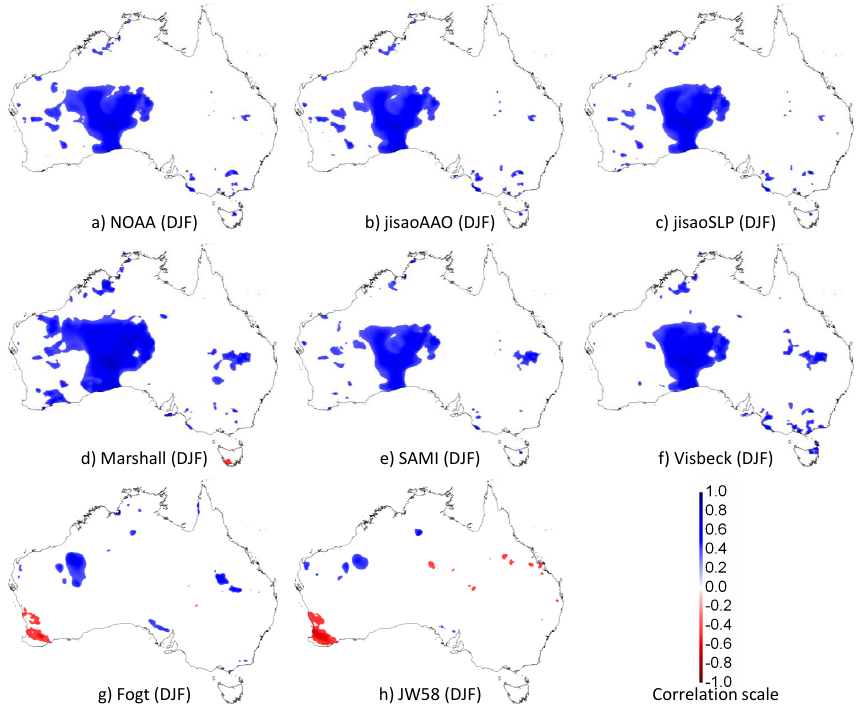
Fig. 4. Correlations between total summer (DJF) rainfall and summer SAM indices, 1979–2002 (a) NOAA; (b) jisaoAAO; (c) jisaoSLP; (d) Marshall; (e) SAMI; (f) Visbeck; (g) Fogt and (h) JW58. Note: only correlations that are statistically significant at the 95th percentile are